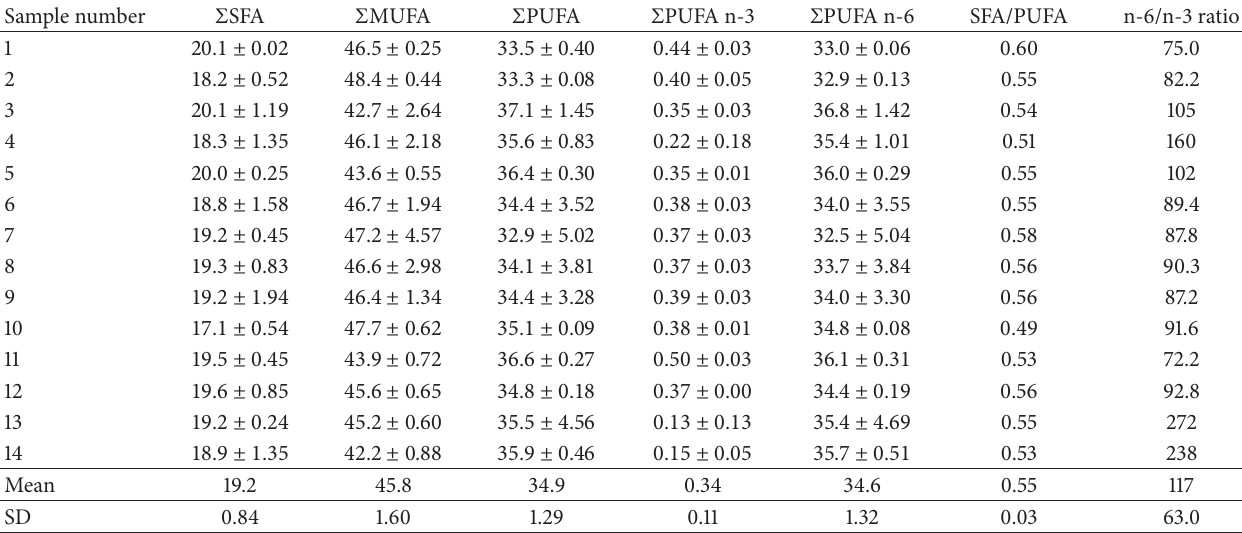
Table 2: Sum of fatty acids in virgin argan oil ∗ .